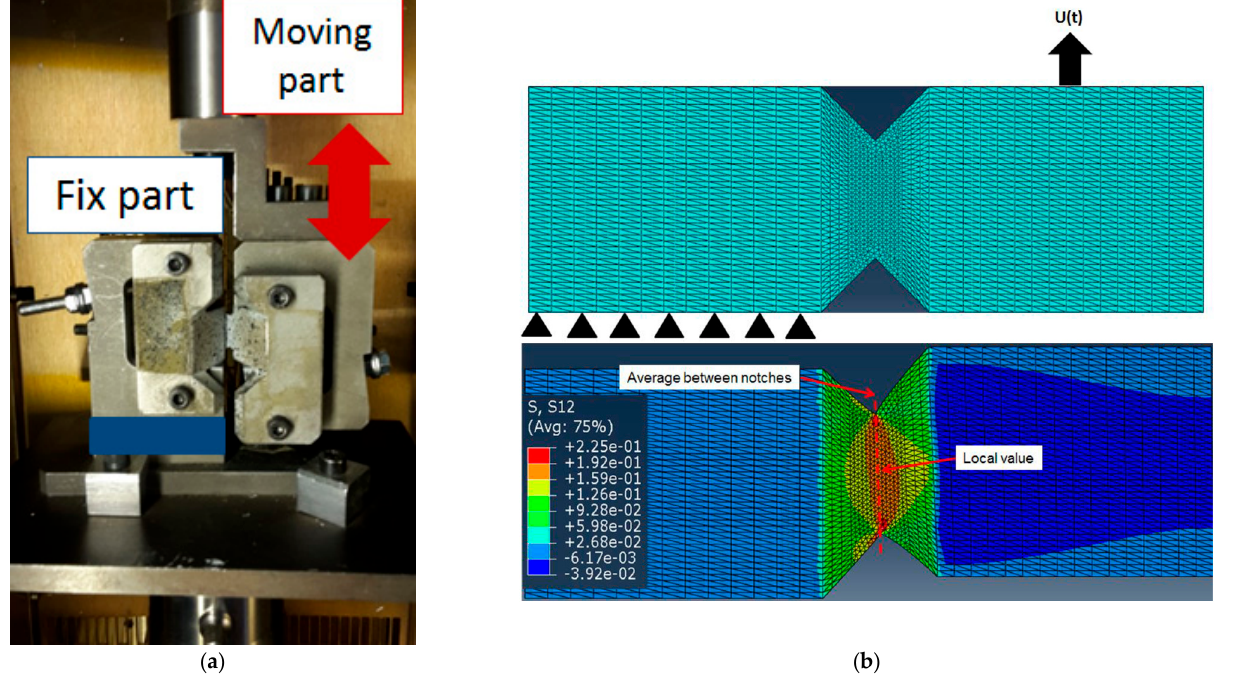
Figure 10 . ( a ) Iosipescu configuration. ( b ) Mesh and boundary conditions for simulations (top right) and equivalent stress contour of the deformed hyperelastic specimen (bottom right).